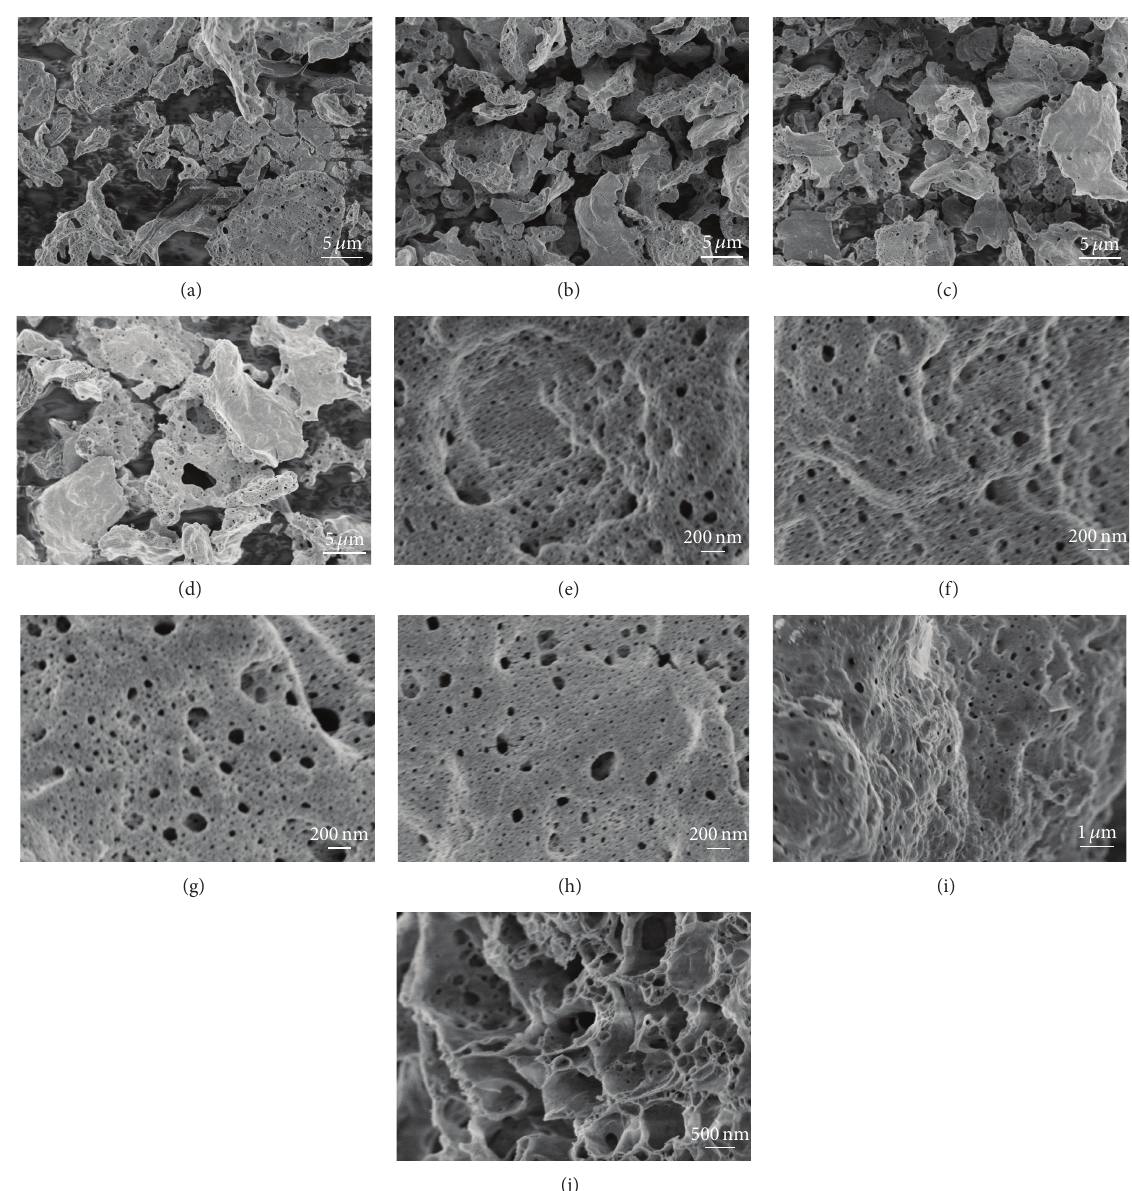
Figure 7: SEM images of Co 3 O 4 /CeO 2 photocatalysts with 5.0 wt.% Co 3 O 4 calcined at 300 ∘ C (a and e), 400 ∘ C (b and f), 500 ∘ C (c and g), 600 ∘ C (d and h), and CeO 2 (i and